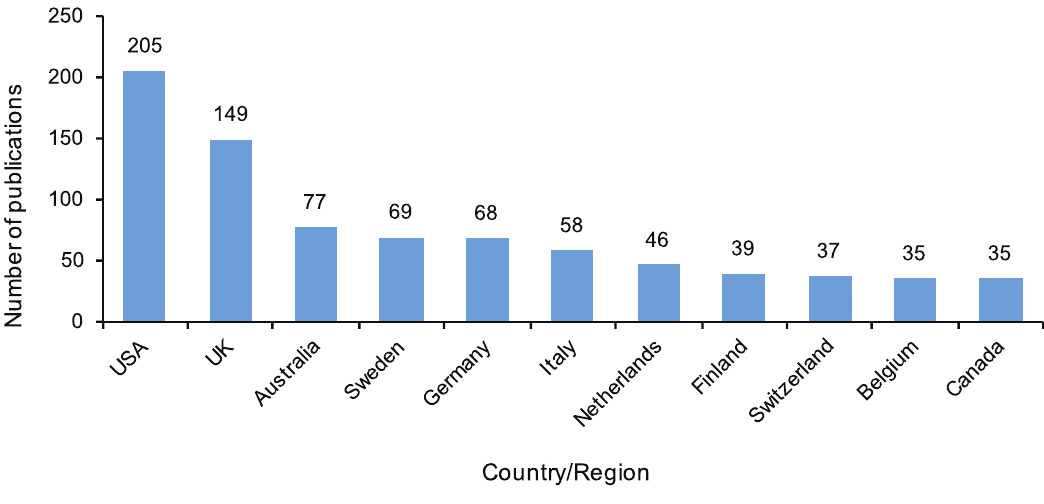
Figure 5: Information of the top 10 countries that contributed the most citations to Research Frontier 2.